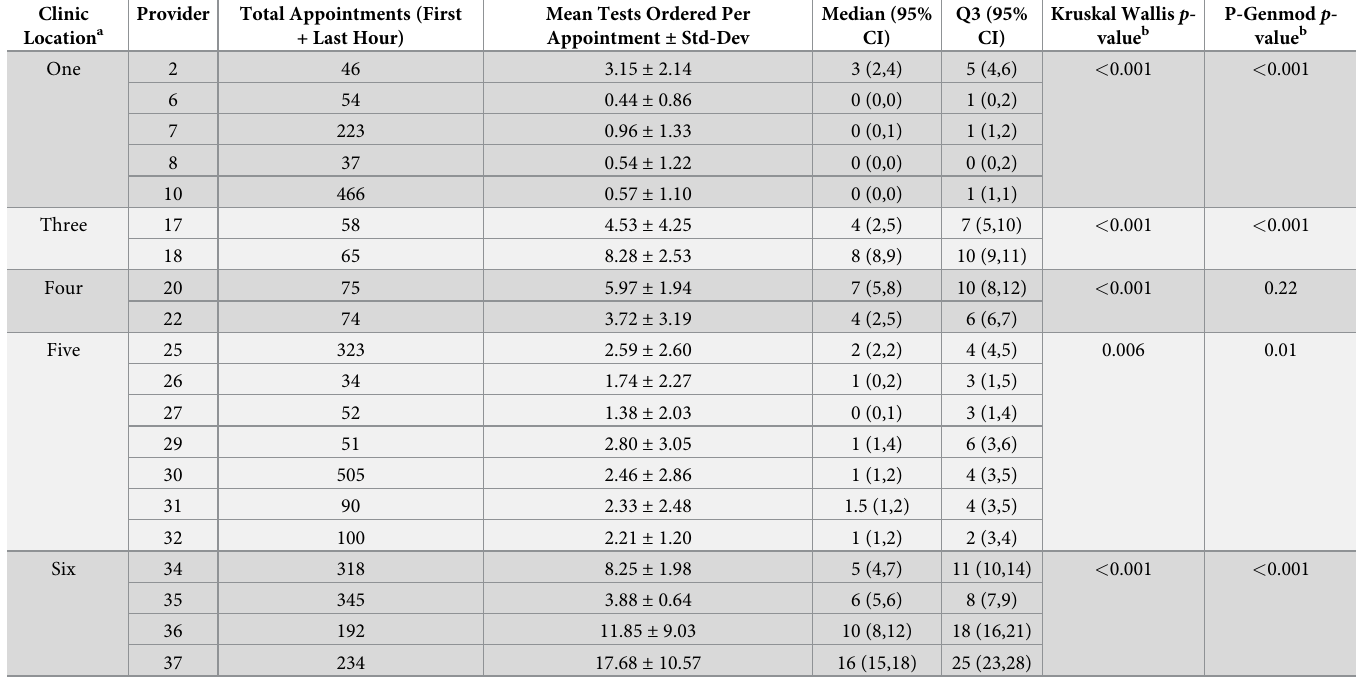
a Each Clinic Location represents a specific specialty. b For within-clinic equality of